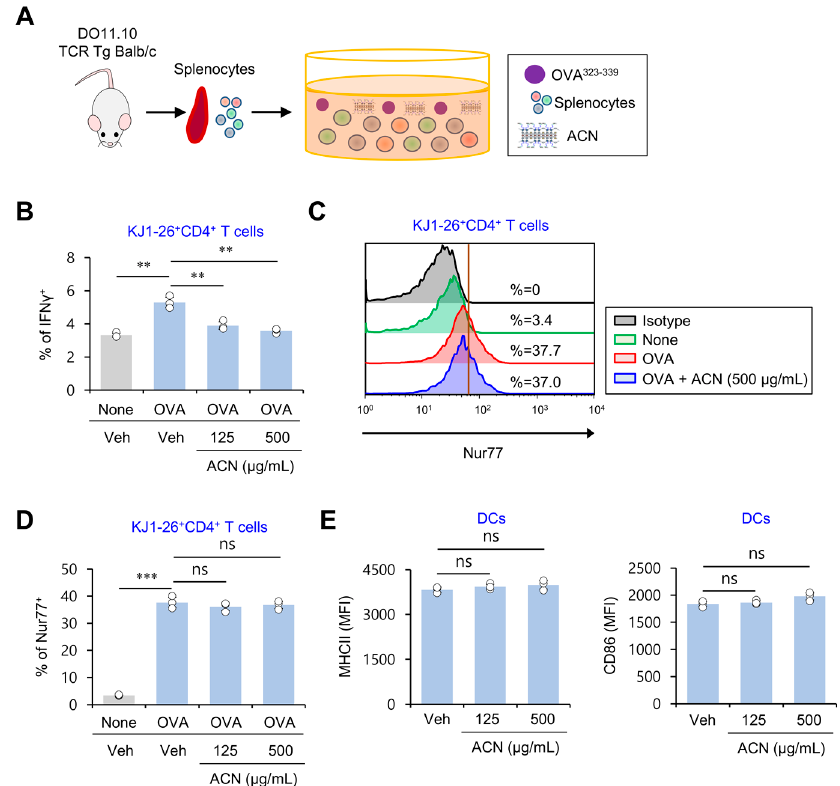
Figure 4. ACN treatment inhibits antigen-specific Th1 polarization independent of TCR signaling strength. ( A – D ) Splenocytes isolated from DO11.10 TCR Tg Balb/c mice were cultured with either Veh or ACNs (125 and 500 µ g/mL) in the presence of OVA peptide 323–339 (10 µ g/mL) for three days. ( B ) Intracellular IFN γ production in CD4 + T cells (KJ1-26 + CD3 ε + CD4 + ) was assessed via flow cytometry. ( C , D ) Intracellular Nur77 expression in CD4 + T cells (KJ1-26 + CD3 ε + CD4 + ) was